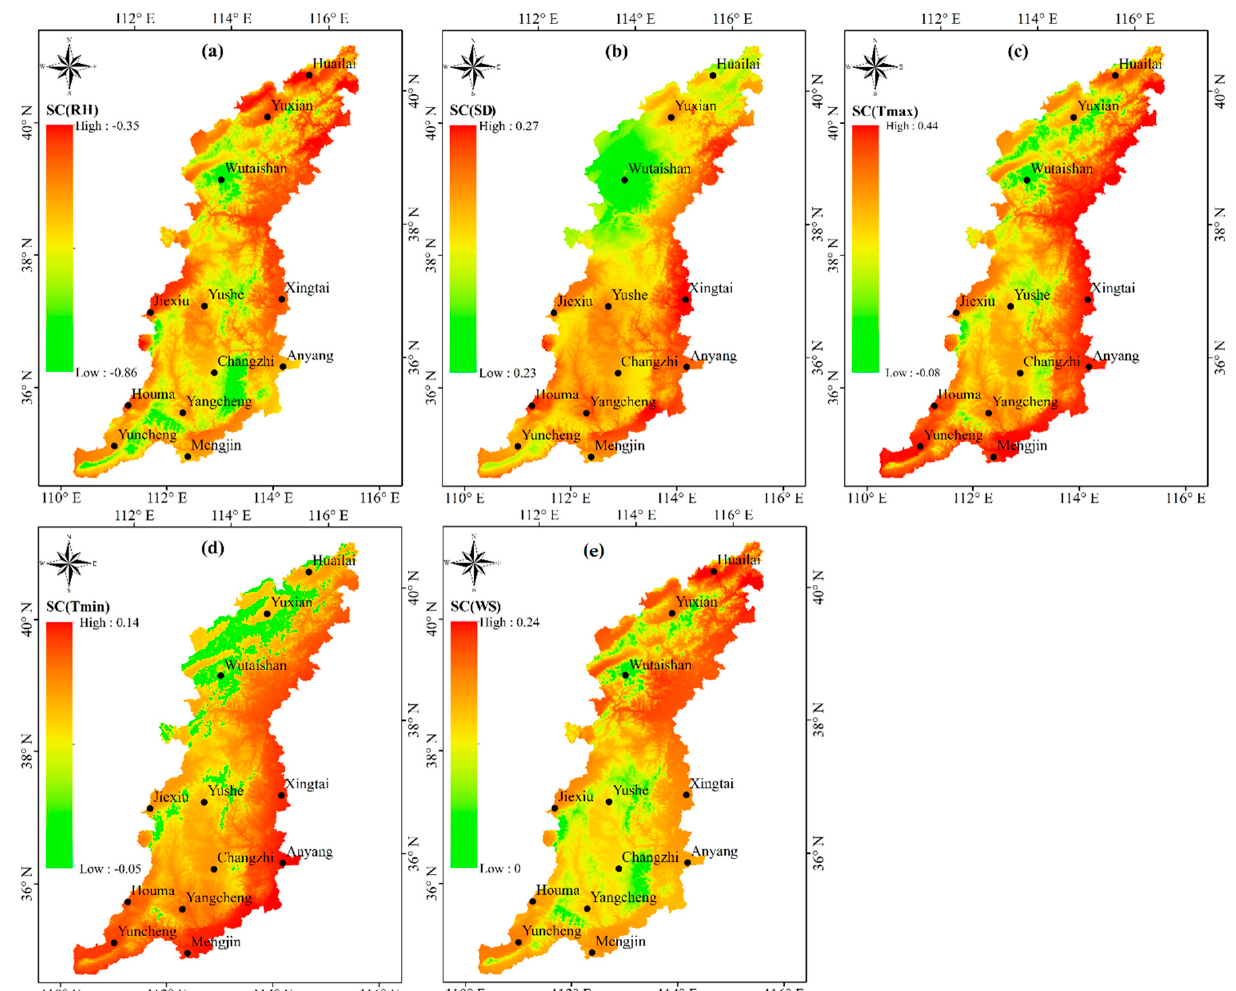
Figure 8. The spatial distributions of the sensitivity coefficients of climatic factors during 1973–2016. ( a ) SC(RH), ( b ) SC(SD), ( c ) SC(Tmax), ( d ) SC(Tmin), ( e )